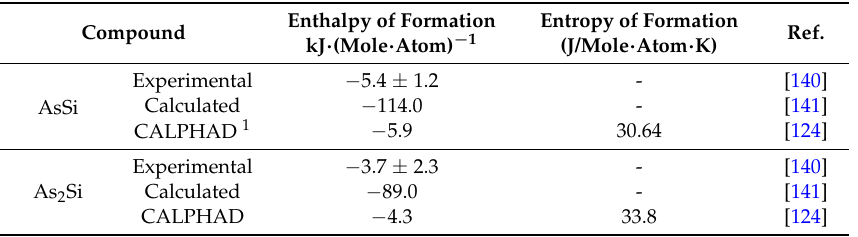
1 Calculations of phase